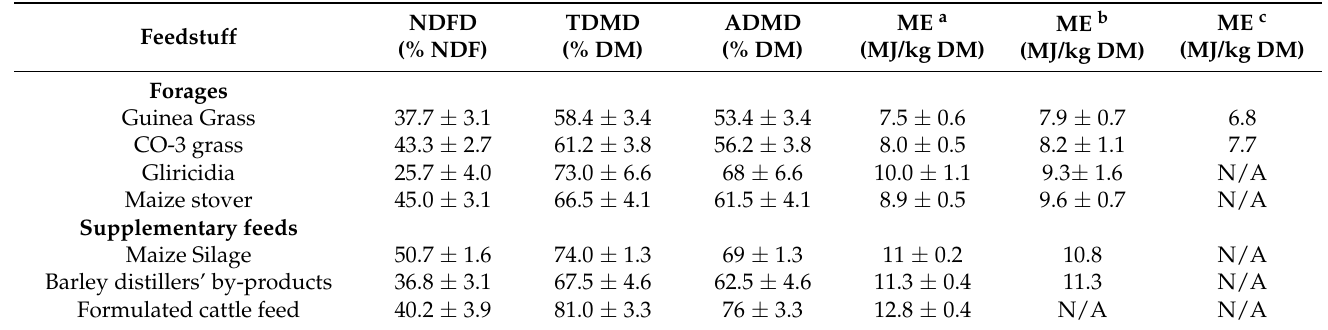
Table 3. Neutral detergent fibre digestibility (NDFD; % NDF), true dry matter digestibility (TDMD, % dry matter (DM)), apparent dry matter digestibility (ADMD, % DM), and metabolisable energy